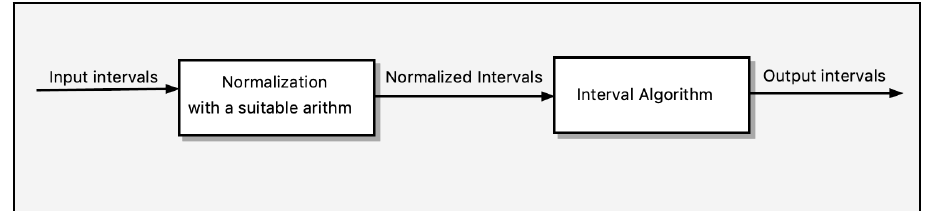
Figure 1. The normalization of input data is done separately from the interval algorithm that solves the problem (which can use a different